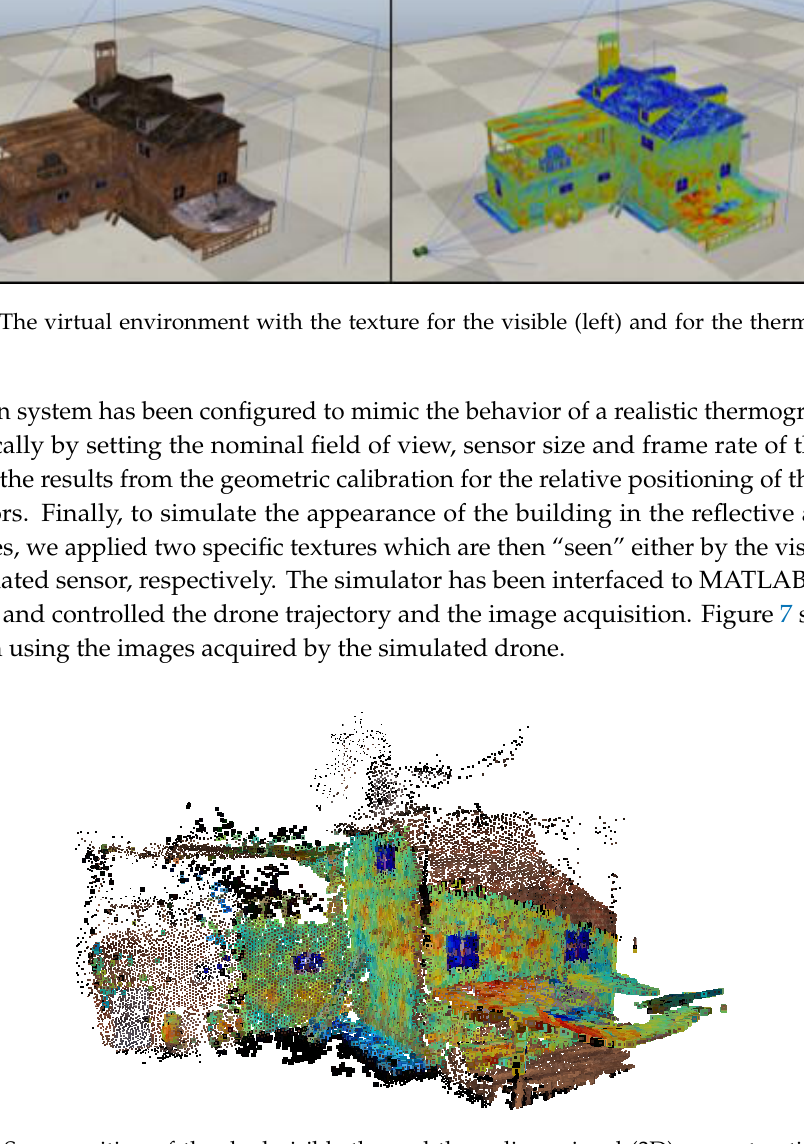
Figure 7. Superposition of the dual visible-thermal three-dimensional (3D) reconstruction of the virtual environment.